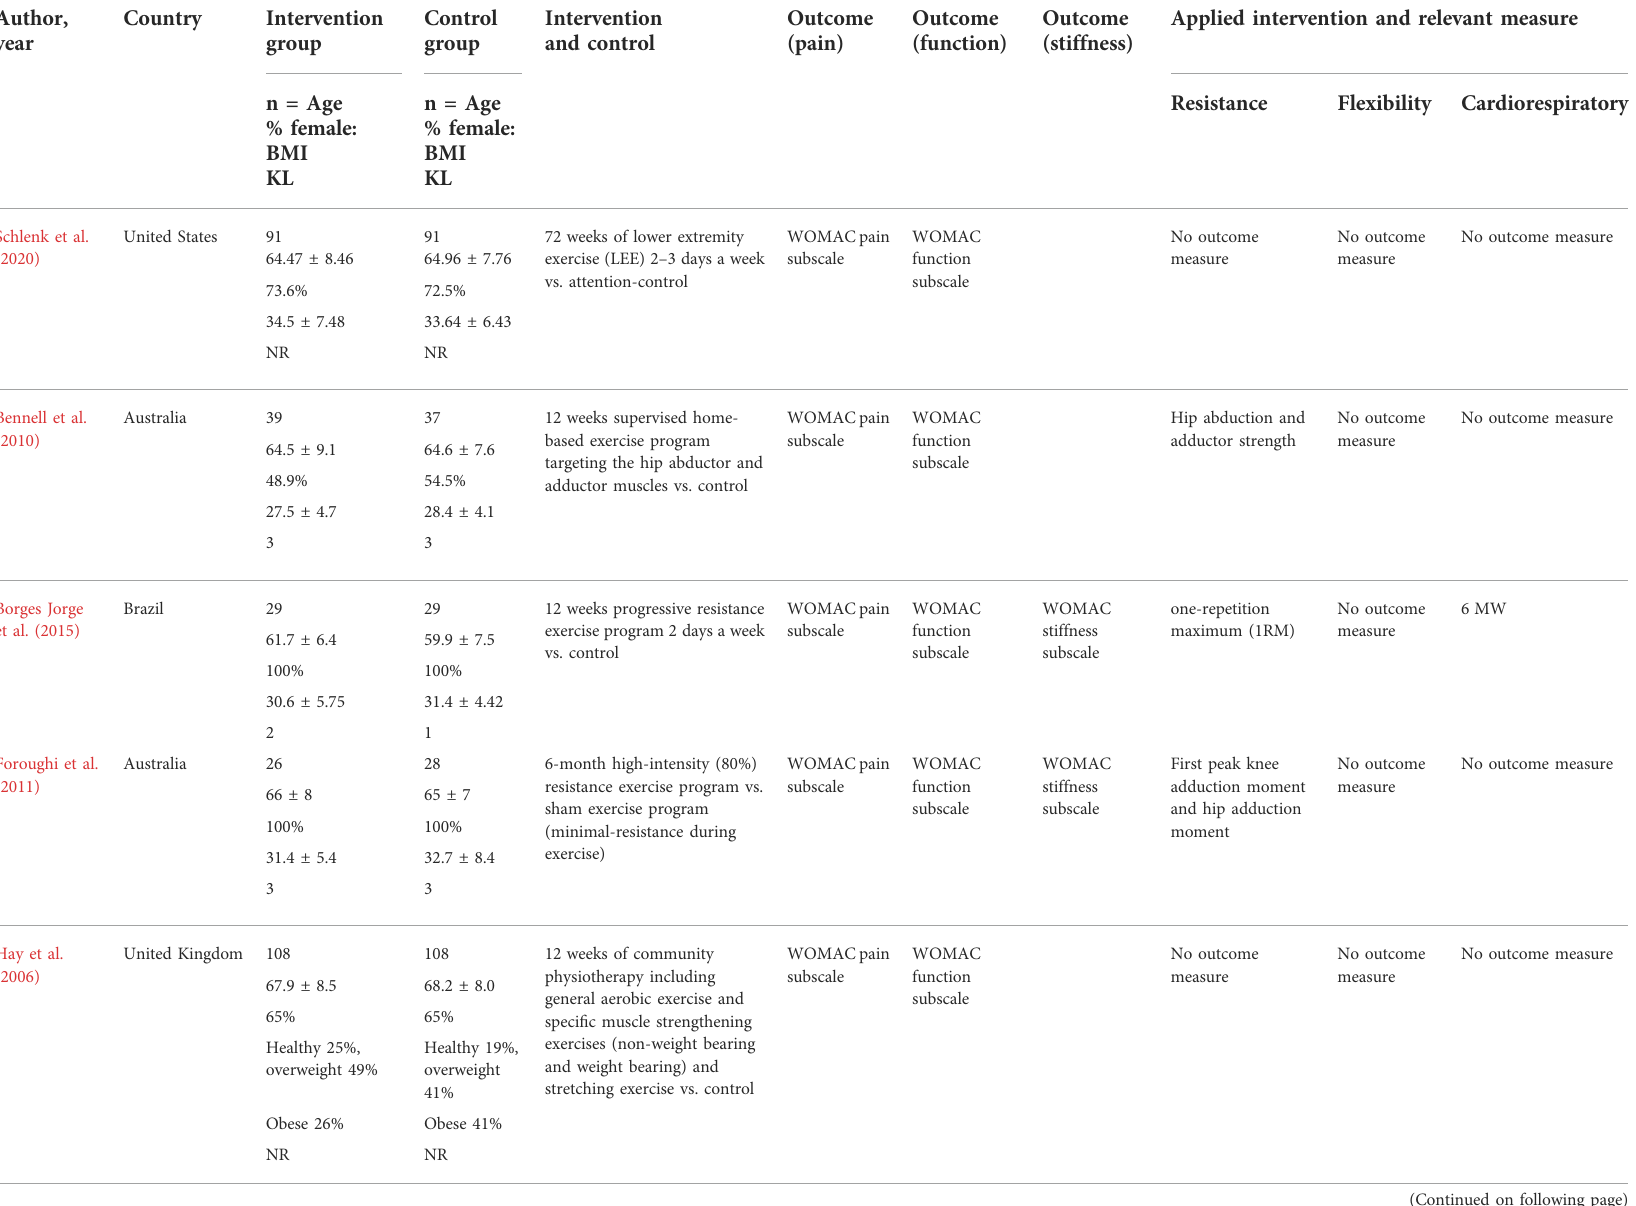
TABLE 4 ( Continued ) Exercise interventions evaluated according to the American College of Sports Medicine ’ s (ACSM)